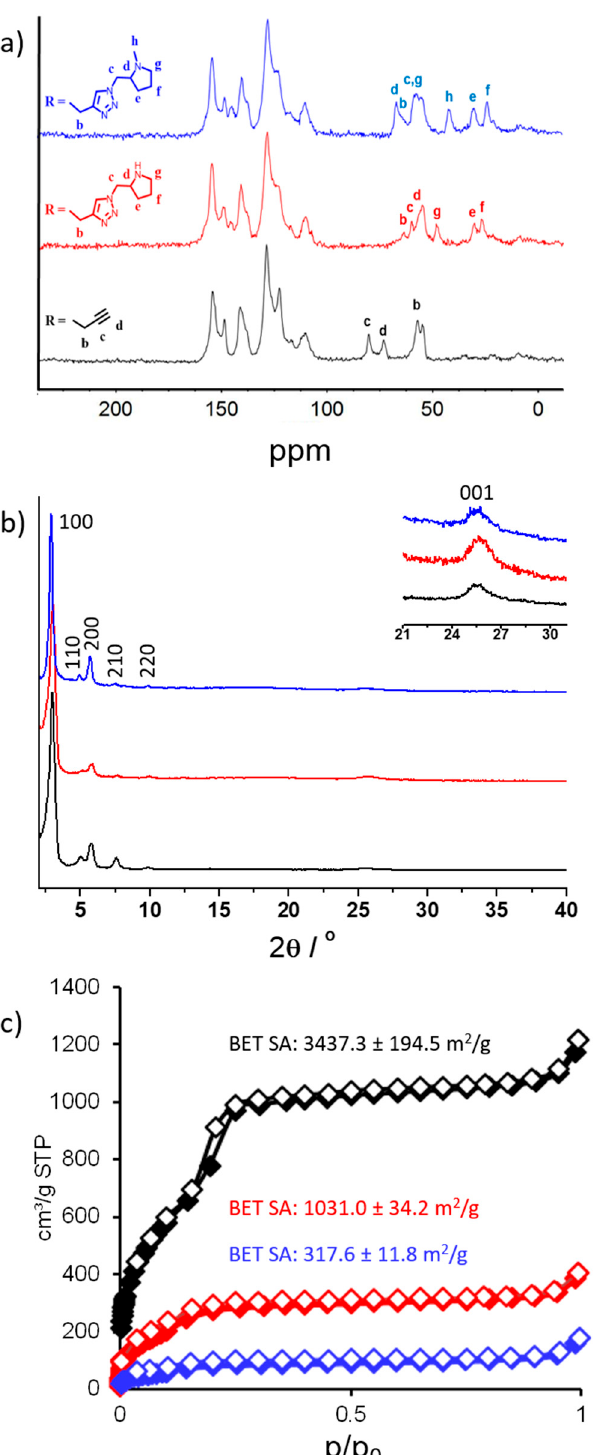
Figure 2. Comparative of ( a ) 13 C CP / MAS NMR spectra, ( b ) PXRD patterns, and ( c ) N 2 adsorption isotherms (77 K) for [HC ≡ C] 0.5 -TPB-DMTP-COF (black line), [( S )-Py] 0.5 -TPB-DMTP-COF (red line), and 1-step-[( S )-PyMe] 0.5 -TPB-DMTP-COF (blue line). Open symbols correspond to the desorption branch.